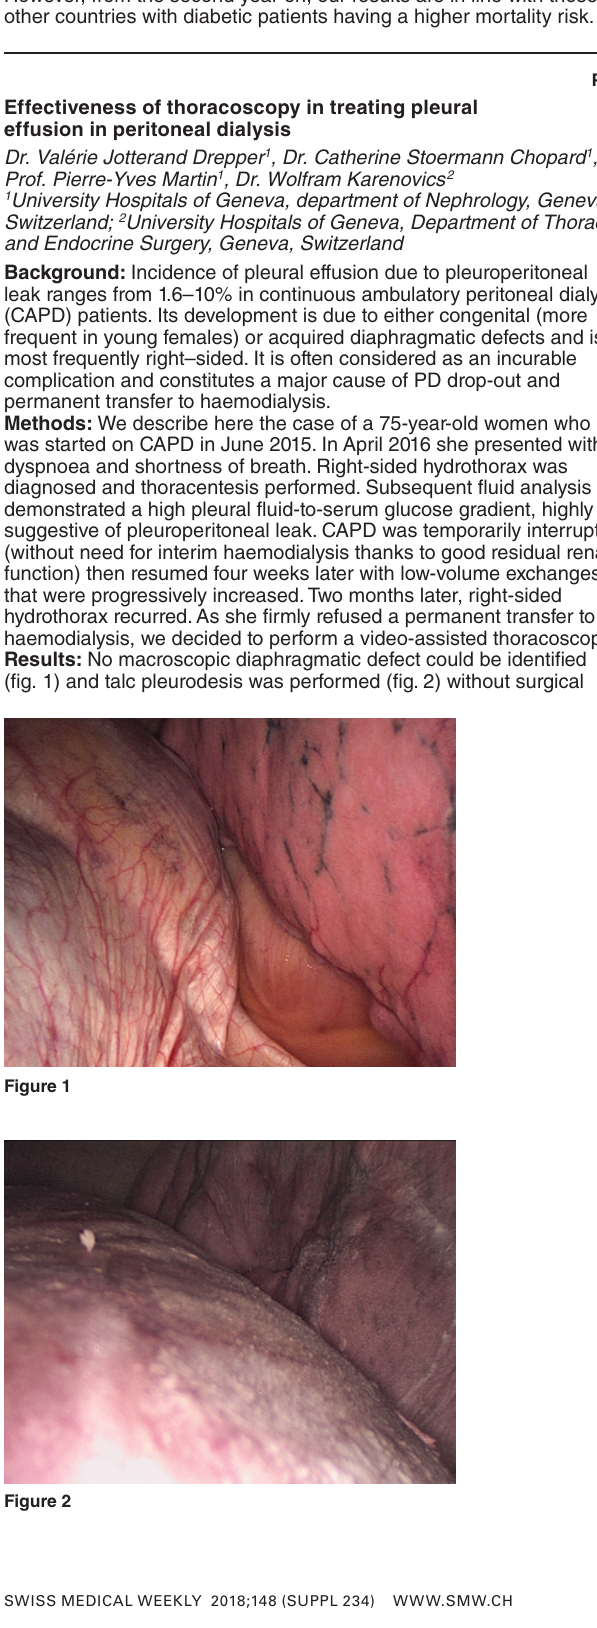
SWISS MEDICAL WEEKLY 2018;148 (SUPPL 234)